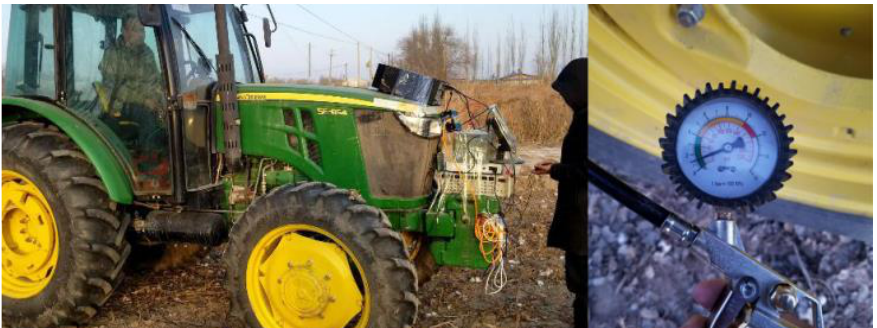
Figure 3. Instrument arrangement and air pressure measurement.